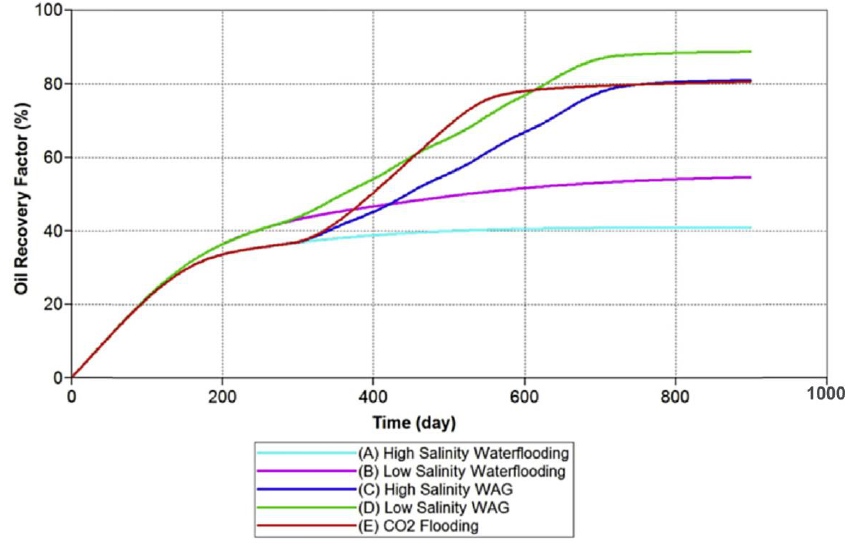
Figure 12. Cumulative oil recovery of different cases